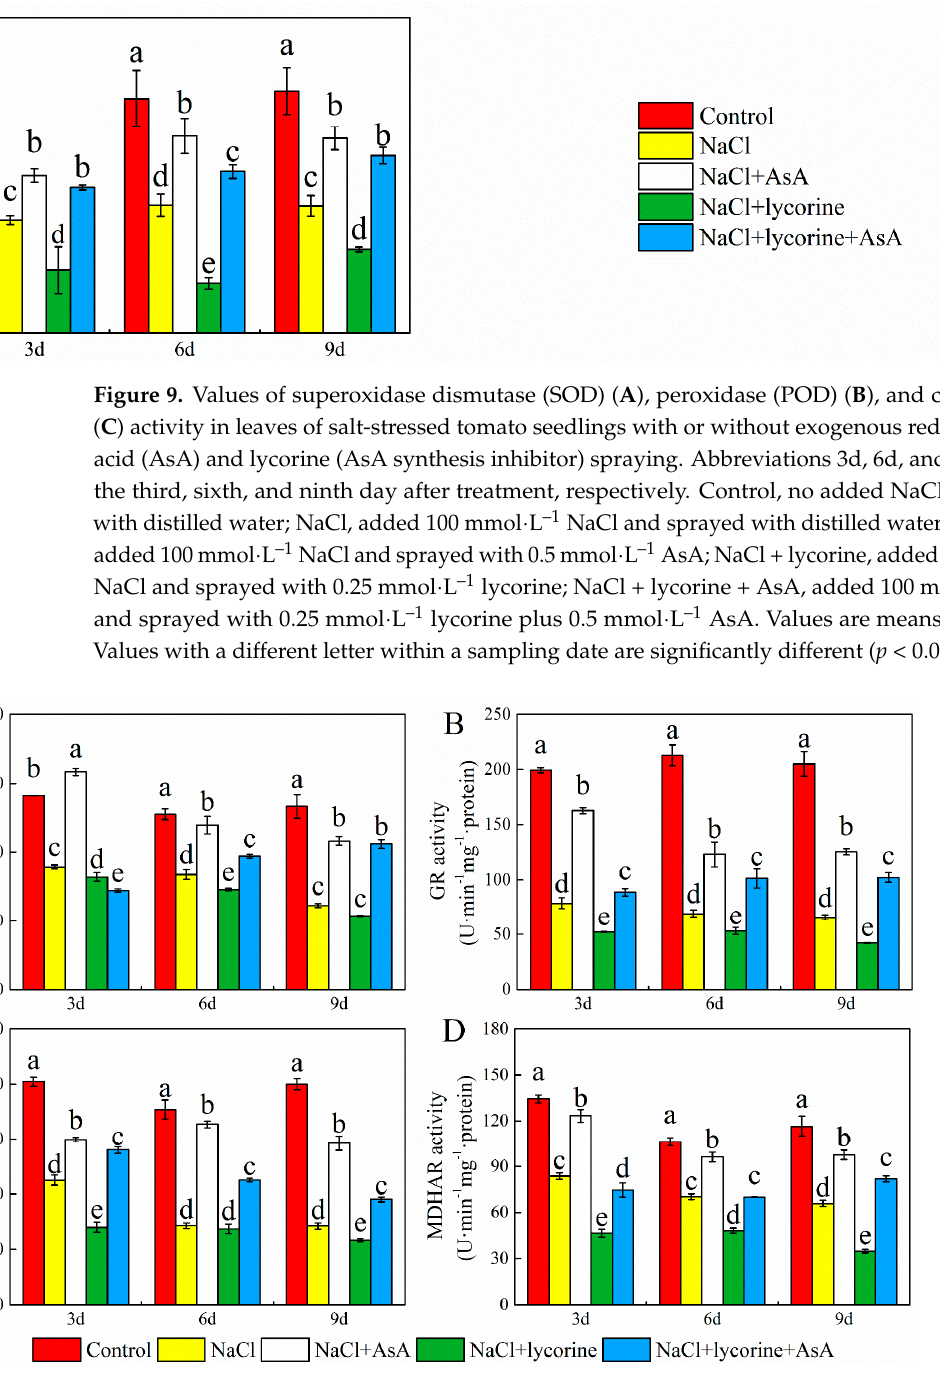
Figure 10. Values of ascorbate peroxidase (APX) ( A ), glutathione reductase (GR) ( B ), dehydroascor- bate reductase (DHAR) ( C ), and monodehydroascorbate reductase (MDHAR) ( D ) activity in leaves of salt-stressed tomato seedlings with or without exogenous reduced ascorbic acid (AsA) and lycorine (AsA synthesis inhibitor) spraying. Abbreviations 3d, 6d, and 9d represent the third, sixth, and ninth day after treatment, respectively. Control, no added NaCl and sprayed with distilled water; NaCl, added 100 mmol · L –1 NaCl and sprayed with distilled water; NaCl + AsA, added 100 mmol · L –1 NaCl and sprayed with 0.5 mmol · L –1 AsA; NaCl + lycorine, added 100 mmol · L –1 NaCl and sprayed with 0.25 mmol · L –1 lycorine; NaCl + lycorine + AsA, added 100 mmol · L –1 NaCl and sprayed with 0.25 mmol · L –1 lycorine plus 0.5 mmol · L –1 AsA. Values are means ± SD ( n = 3). Values with a different letter within a sampling date are significantly different ( p <